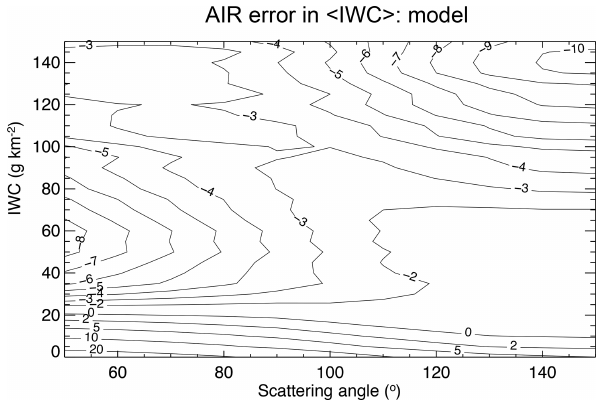
Figure 2. Relative errors of ensemble averages, (cid:104) IWC (cid:105) using the AIR approximation, taken over all cloud model simulations for con- ditions of summer solstice. (cid:104) IWC (cid:105) is thresholded by the variable IWC in the vertical axis, so that (cid:104) IWC (cid:105) applies to all values above IWC. Contour lines are labeled as percent errors relative to the ac- curate model values.